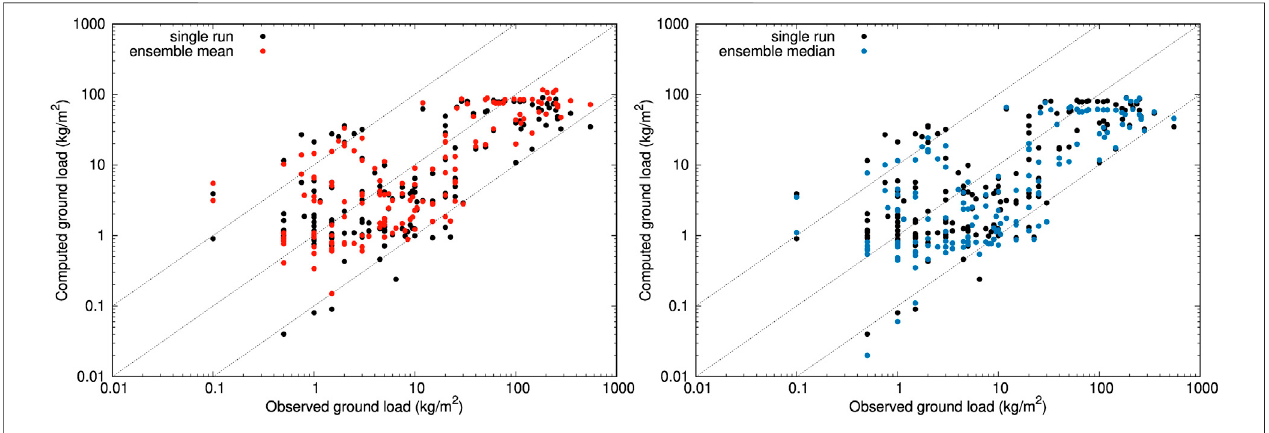
FIGURE 6 | Validation of Calbuco runs in 159 deposit points. Deposit thicknesses are converted to deposit loads (kg/m 2 ) assuming an averaged density of 1,000 kg/m 3 . Left:single-run (black points) versus ensemble mean (red points).Right: single-run (black points) versus ensemble median (blue points). Forreference, the three dashed lines show the perfect fi t and the 10 model over and under-estimation bounds. The resulting global values of the NRMSE are reported in Table 6 .